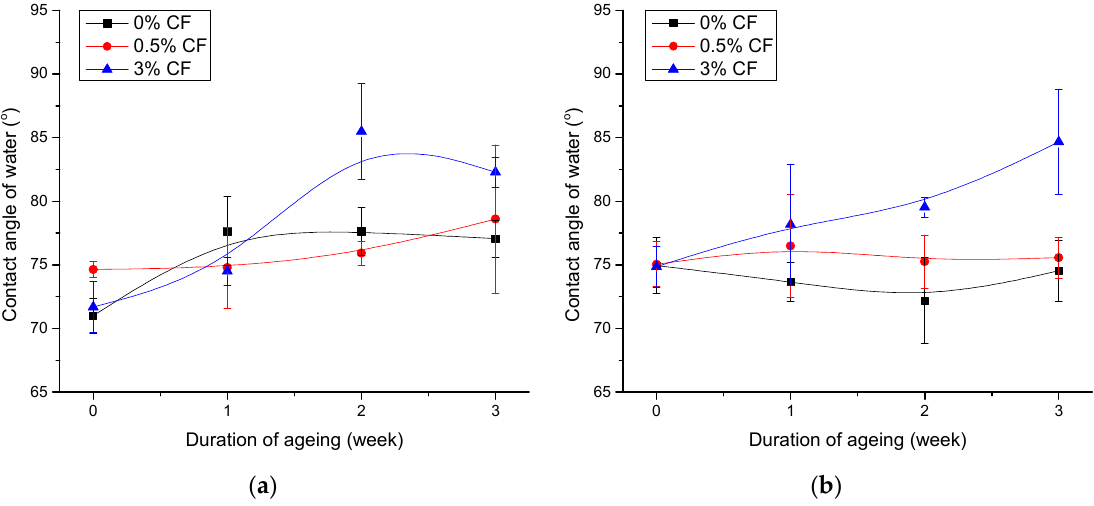
Figure 11. Contact angle of water on aged PCL/PLA/CF blends with addition of coconut fibers: ( a ) 100/0 and ( b ) 70/30.